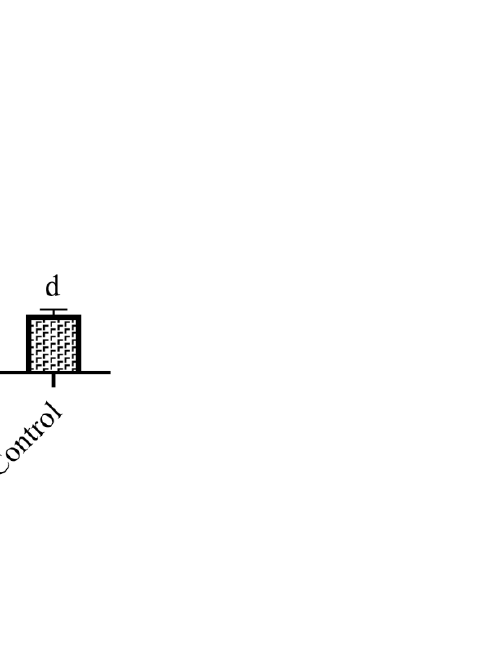
Figure 2. The mean number of eggs of Ae. aegypti to various color ovitraps in the field. These letter shows significant difference among treatments.